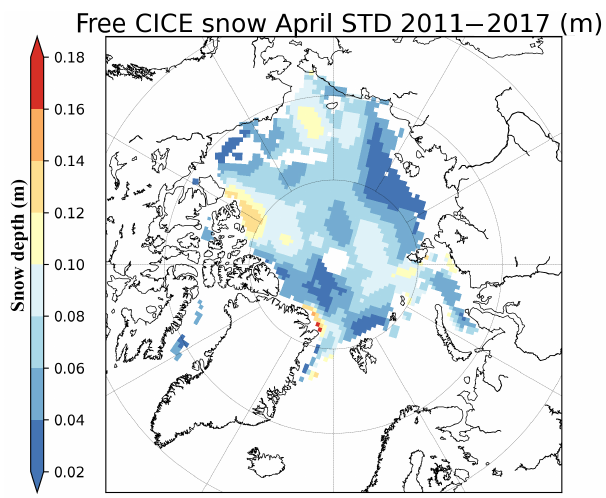
Figure 10. Standard deviation of CICE-simulated snow depth using NCEP-2 reanalysis for the month of April from 2011 to